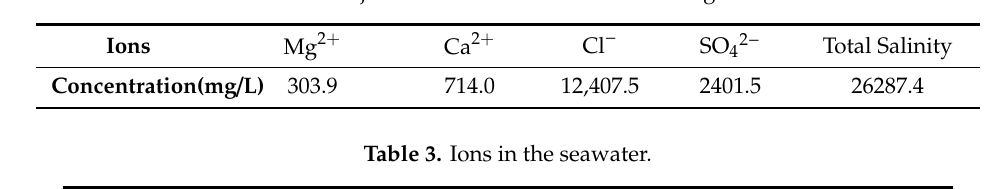
Table 2. Major ions content of the marine dredger fill.